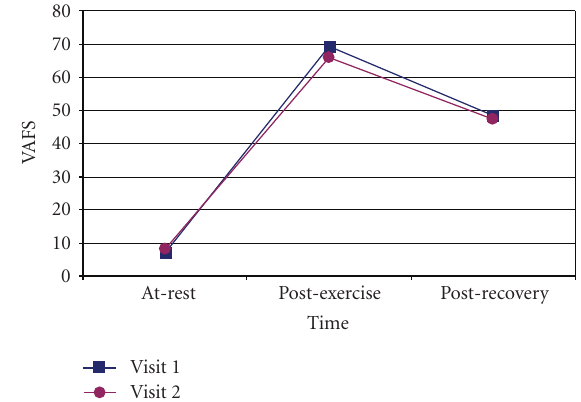
Figure 2: VAFS measures at rest, post exercise, and post recovery from Visits 1 and 2. VAFS: Visual Analog Fatigue Scale.